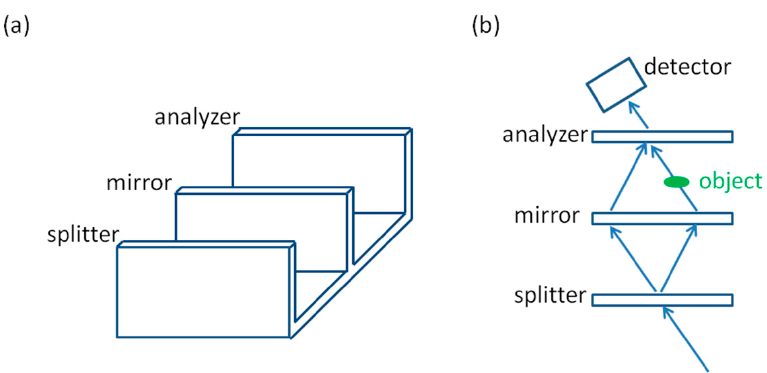
Figure 9. Sketch of ( a ) the crystal interferometer instrument and ( b ) its wave